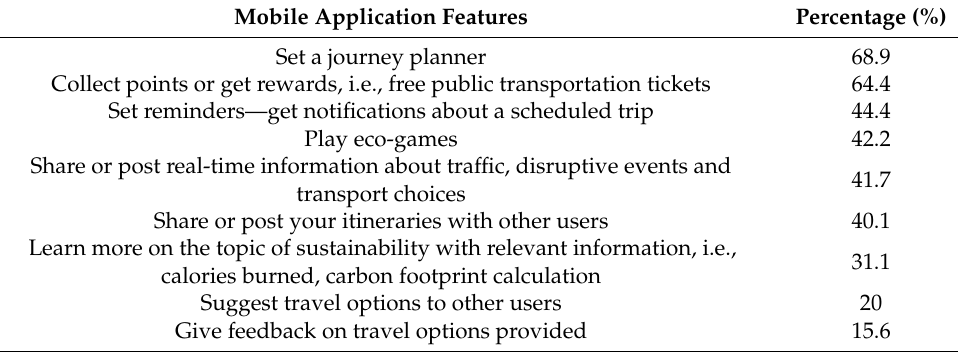
Table 3. Features that pupils like to have in a mobile travel application in order to use it